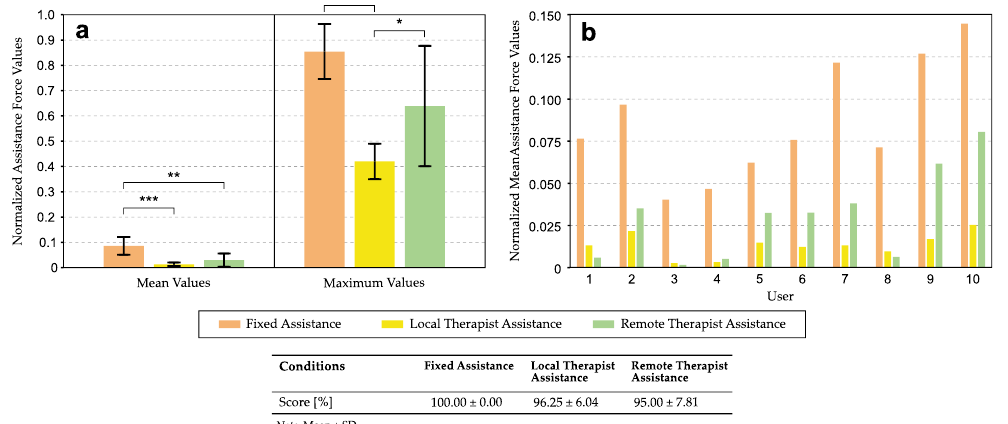
Figure 10. Normalized assistance force values. ( a ) Mean and maximum assistance forces values in every condition for all patients. Bars indicate mean values, and error bars indicate standard deviations. ( b ) Mean assistance force value in every condition for each patient. In all cases, each patient’s assistance force was normalized by the maximum value measured for the patient throughout the three conditions. The table collects the mean percentage and the standard deviation of the score in every condition for all patients. Statistical differences are represented by * ( p < = 0.05), ** ( p < = 0.01) *** ( p < = 0.001) and **** ( p < =